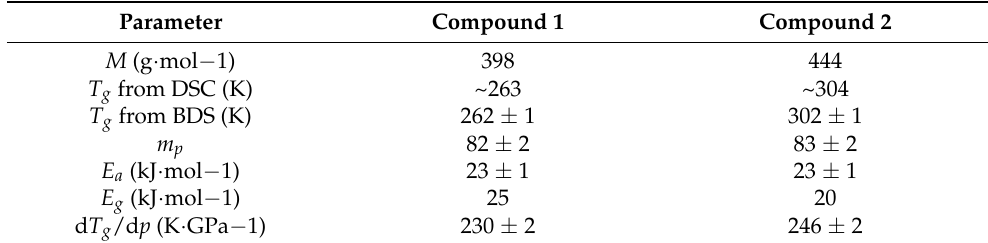
Table 1. Molar mass ( M ), glass transition temperature ( T g ) calculated from DSC and BDS experiments, ambient-pressure fragility index ( m p ), activation energy for secondary relaxation ( E a ), energy barrier for rotation of the changeable substituent ( E g ) and pressure coefficient of glass transition temperature (d T g /d p ) for compounds 1 and 2 .